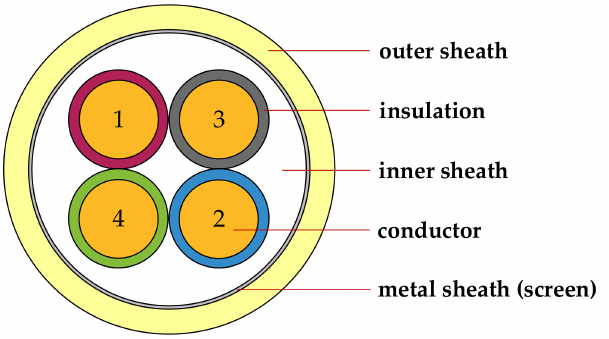
Figure 1. Cross section of the communication cable consisting of conductors 1 to